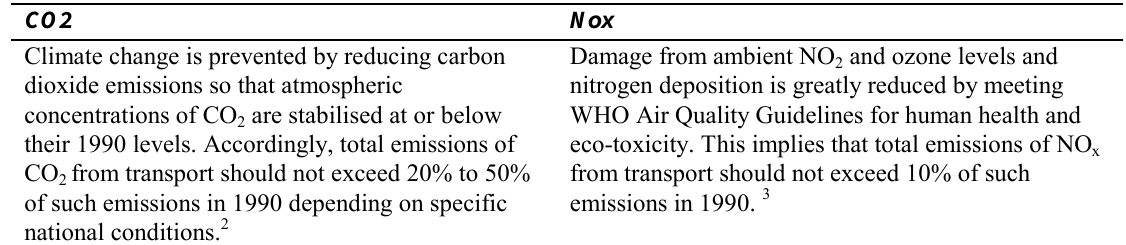
Table 1. Illustrative long-term environment and health quality objectives, criteria, and derived operational targets for